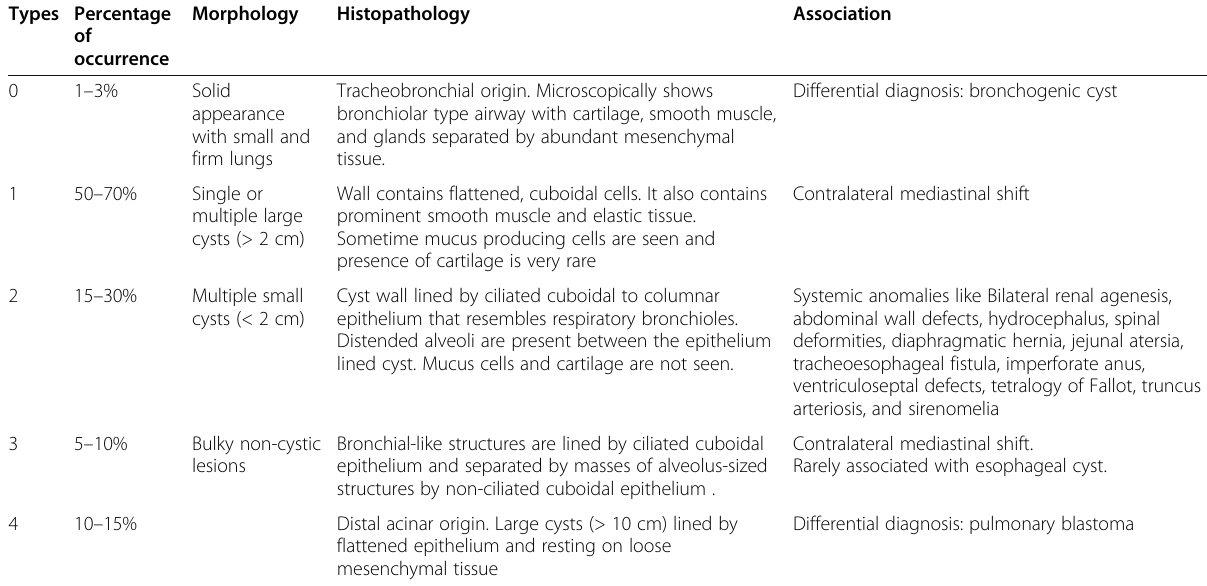
Table 1 Stocker classification of congenital cystic adenomatoid malformation [4, 5, 8] Types Percentage